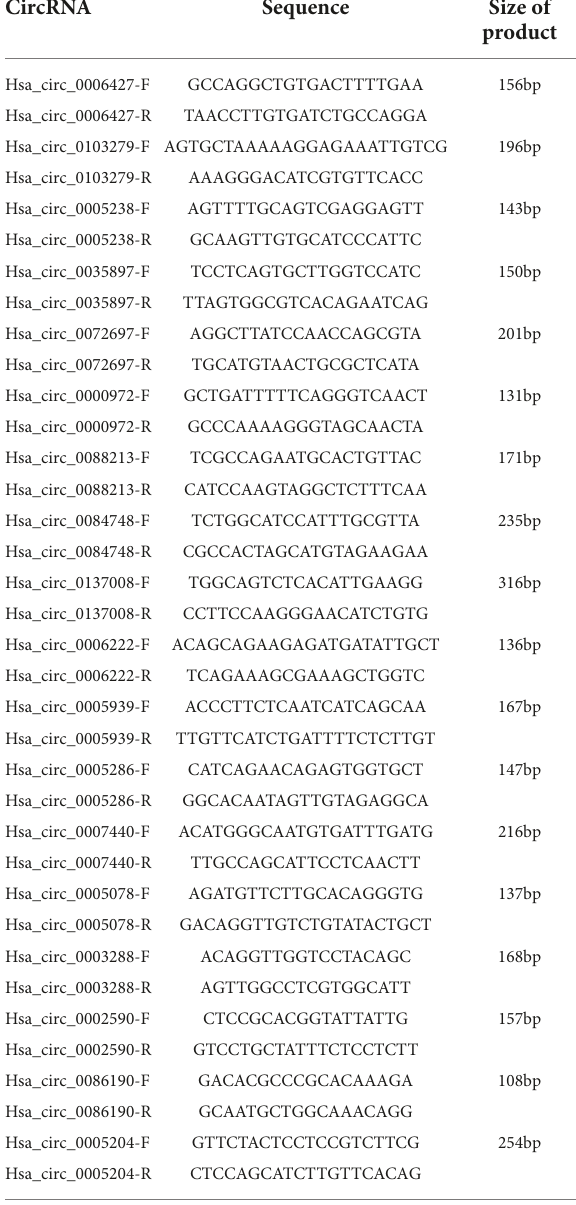
TABLE 1 Primer of circular RNAs